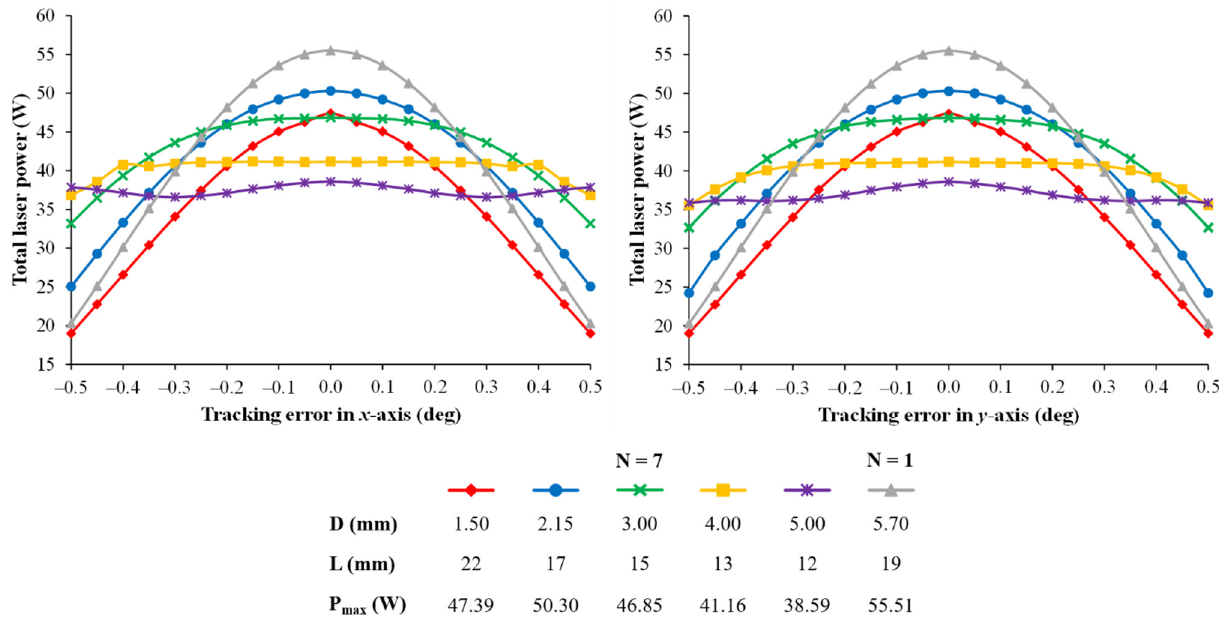
Table 1 to facilitate the assessment of the tracking error compensation capacity and power stability, respectively, of each case.